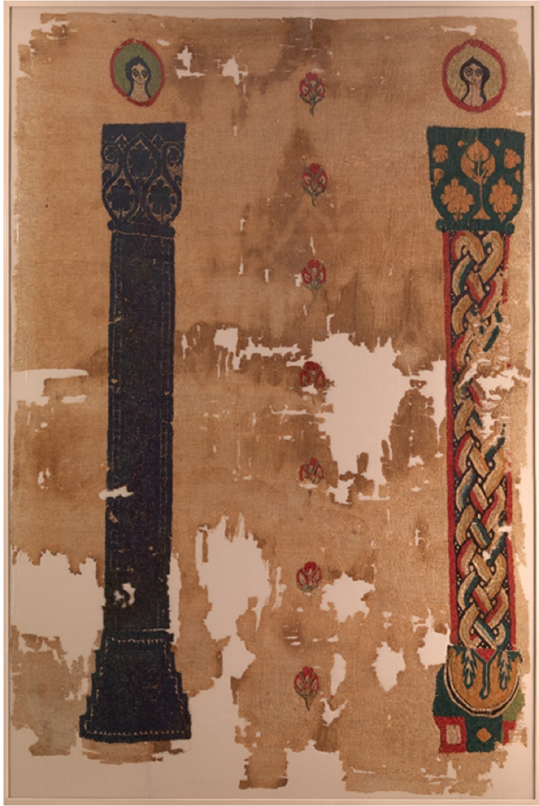
Figure 23. Hanging with Polychrome Columns , 5th–6th century CE. Found Egypt, near Damietta. Linen, wool; tapestry weave; overall: H. 90 1/2 in. (229.9 cm), W. 61 1/2 in. (156.2 cm). Metropolitan Museum of Art, Gift of Arthur S. Vernay Inc., 22.124.3. Digital image available under Creative Commons license CC0 1.0.